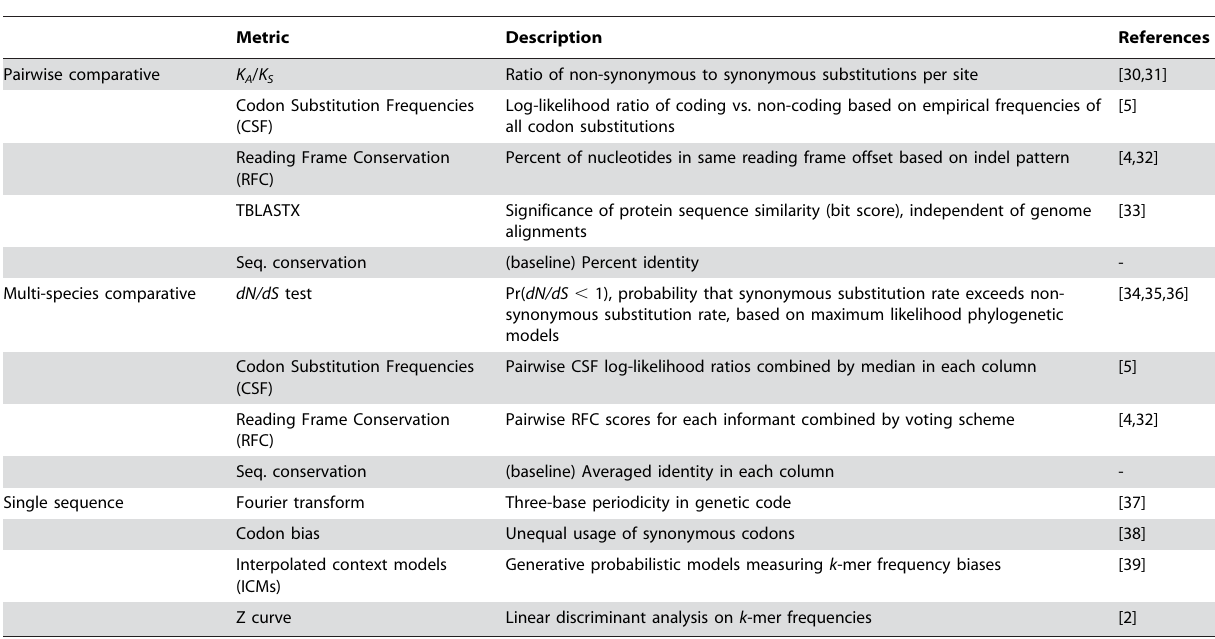
Table 1. Discriminative metrics for gene